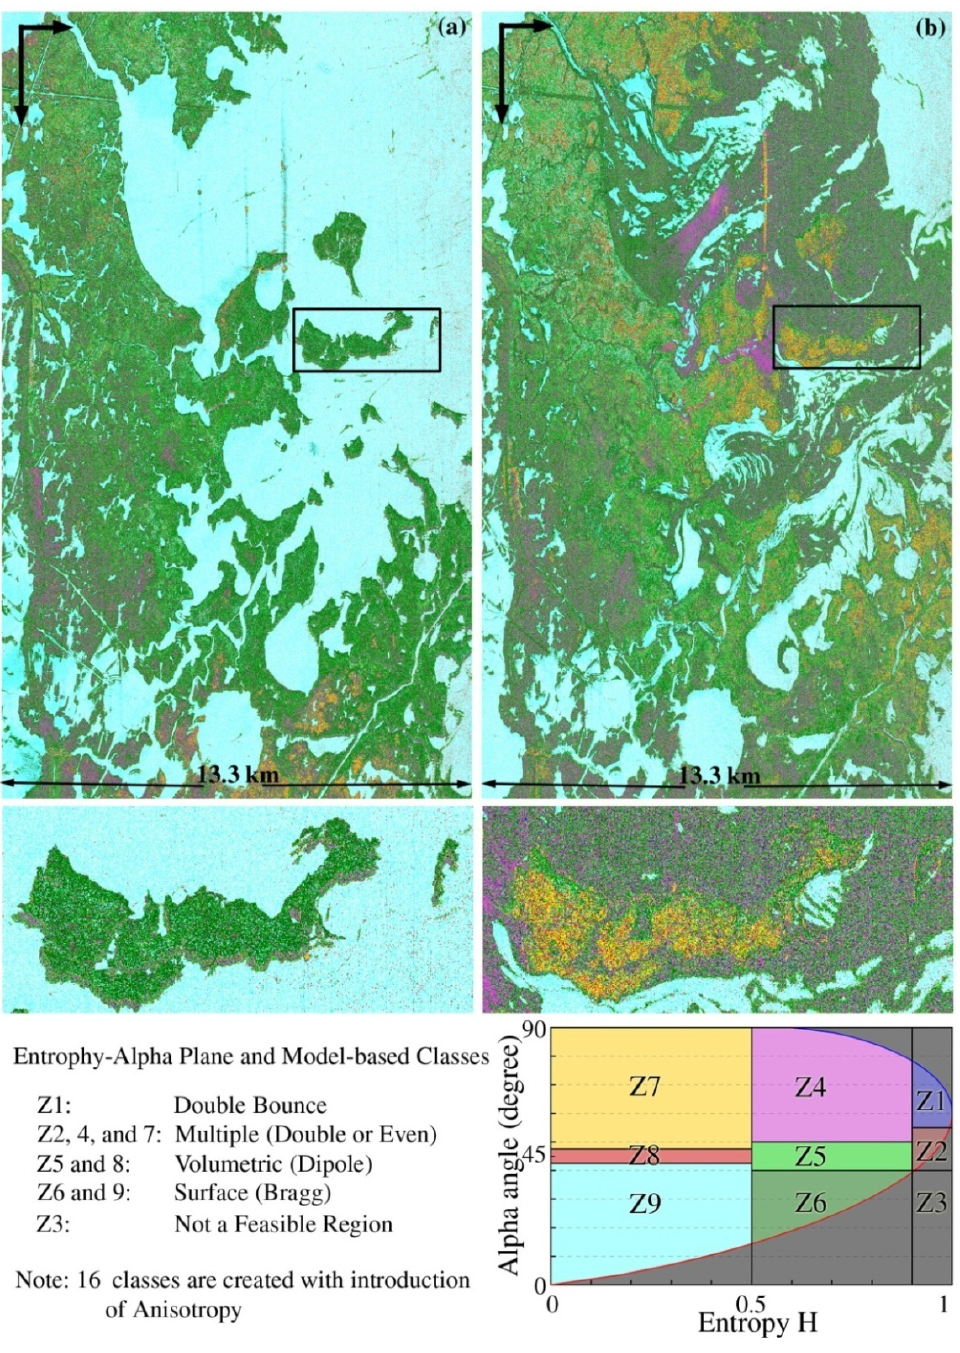
Figure 10. Results of the CP decomposition of the 2009 (a) and 2010 (b) MLC data of the MRD flight lines. The same color reference table was used in 2009 and 2010